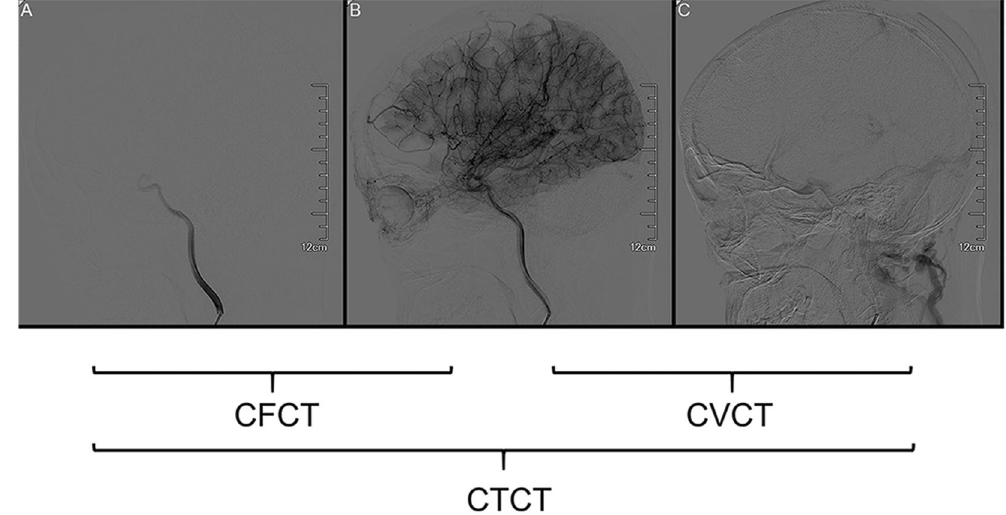
Figure 1. The schematic diagram of measurement of cerebral circulation time. The lateral view of internal carotid artery. CTCT: The time from appearance of the C4 segment of ICA to disappearance of the sigmoid sinus; CFCT: The time from appearance of the C4 segment of the ICA to maximum intensity of contrast; CVCT: The time from maximum intensity of contrast to disappearance of the sigmoid sinus.